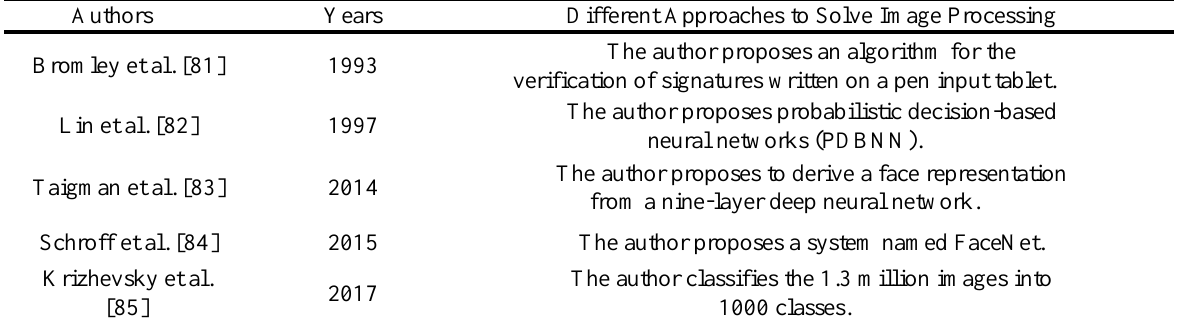
Table 3. A literature review of deep learning methods for face